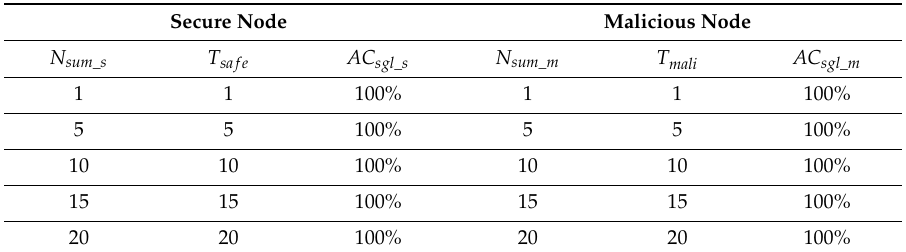
Table 2. Accuracy result with a single node.